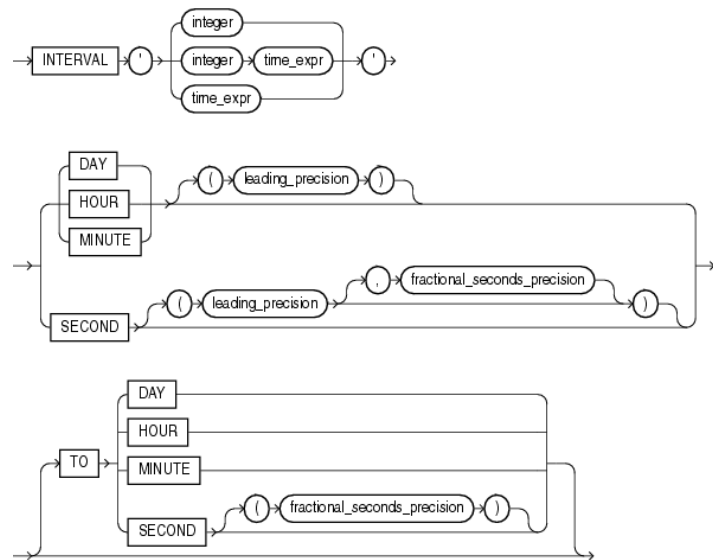
Figure 15. Interval Day to Second—syntax [39].